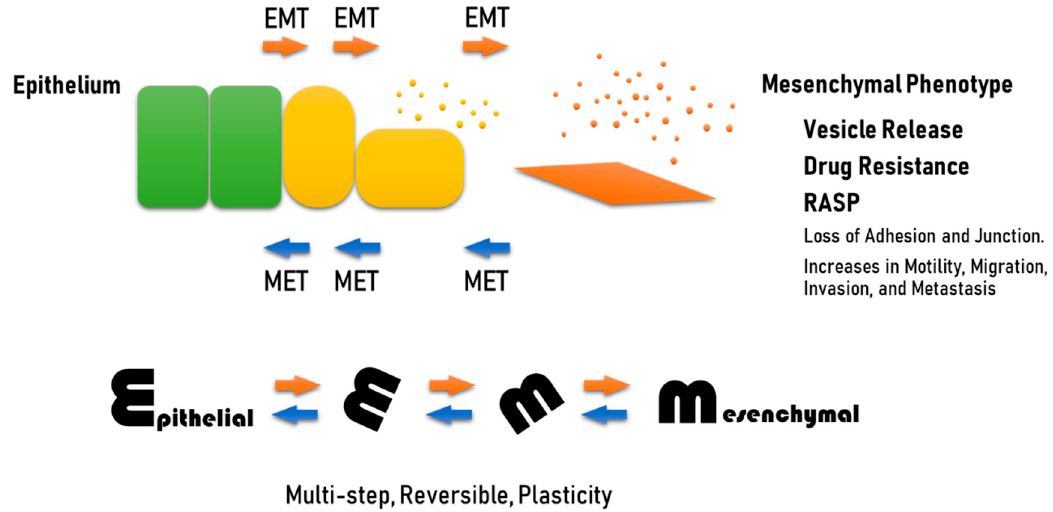
Figure 1. EMT, a process coupled with vesicle release, drug resistance, and RASP. EMT is a reversible process, which means that although epithelial cells can be switched into a mesenchymal phenotype (EMT), such cells can also revert to epithelial cells by undergoing mesenchymal-epithelial transition (MET). Both EMT and MET occur during normal development and during cancer progression. Epithelial cells adhere to each other through epithelial intercellular adhesion molecules (i.e., E-cadherin and claudins) and desmosomes, which are often lost in EMT. During EMT, cells become motile and acquire invasive capacities.